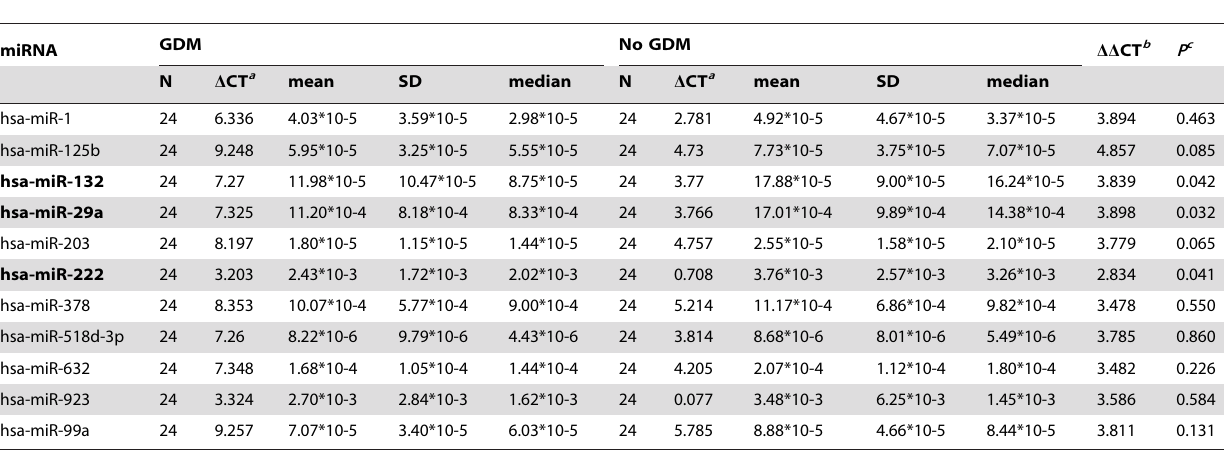
Table 2. Results of 11 miRNAs in the discovery stage.